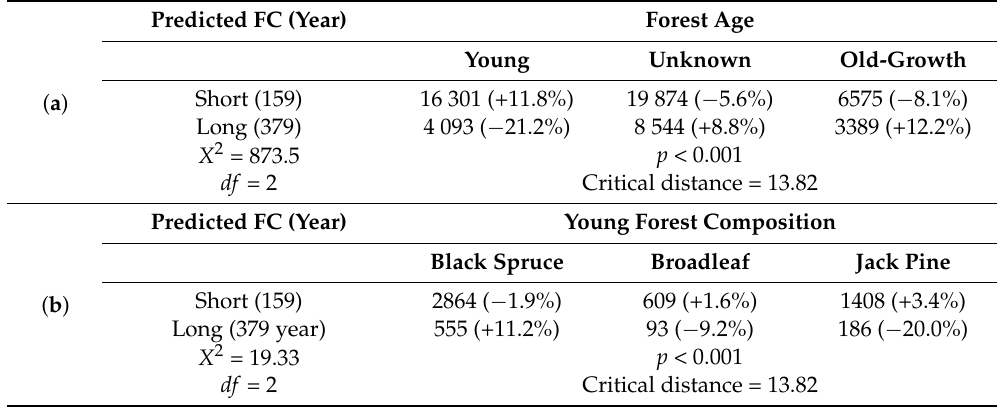
Table 6. Contingency tables and chi-square ( X 2 ) test of observed frequencies and their deviance from expected frequencies (in parentheses) for (a) young, unknown (mature or old-growth) and old-growth forest types and (b) young forest compositions in short and long FC